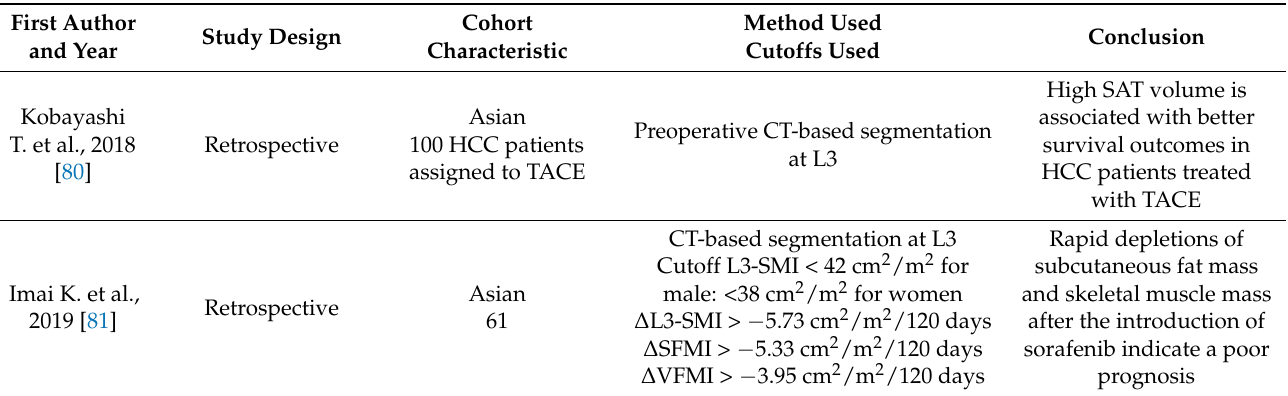
Table 3. Studies assessing the correlation between subcutaneous adipose tissue and the outcome of HCC patients published in the last 5